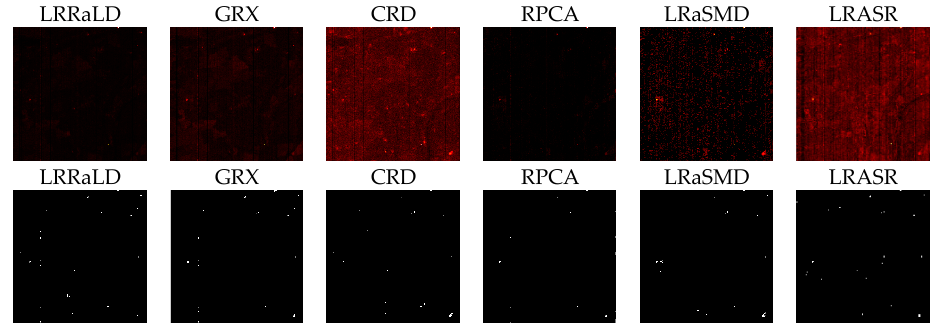
Figure 15. Detection results of Hyperion data set: ( top ) 2-D display; and ( bottom ) binary results when PFA equals 0.001.